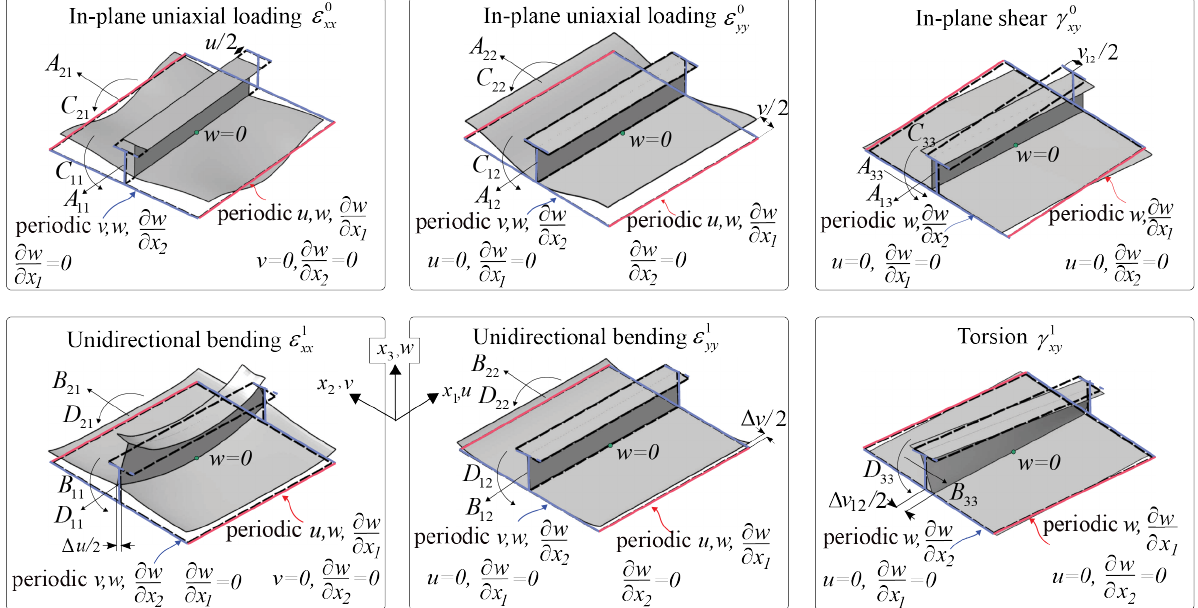
Figure 2. Six different unit cell (UC) configurations with boundary conditions needed for ABCD stiffness matrix definition. Forces and moments shown with arrows are associated with respective stiffness components. Boundary conditions for edges with the same color are